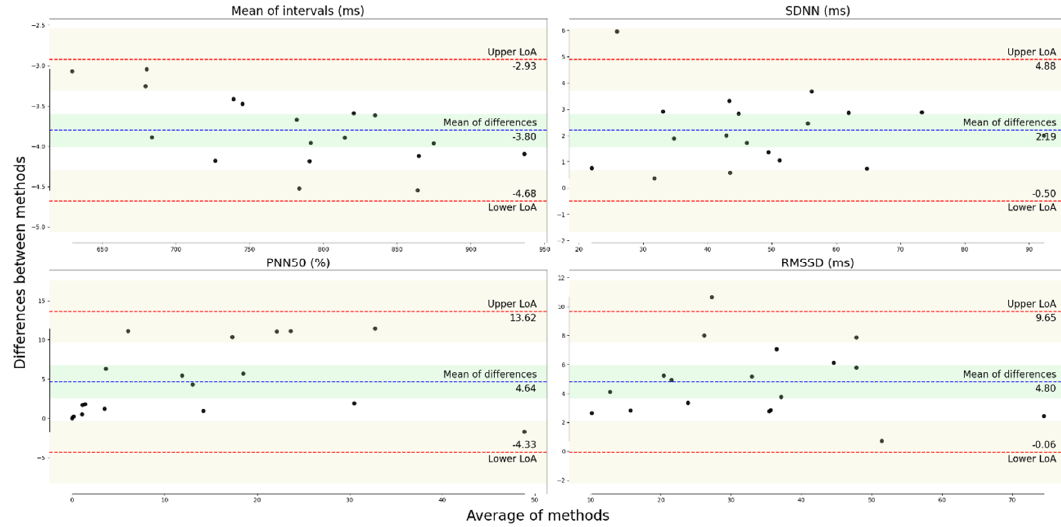
Figure A1. Bland–Altman plots for the pairs of time-domain metrics obtained at rest. The blue line and the green area represent the mean of the di ff erences between measurements and the associated confidence interval. The red lines and the associated area represent the upper and lower LoAs and the associated confidence intervals.